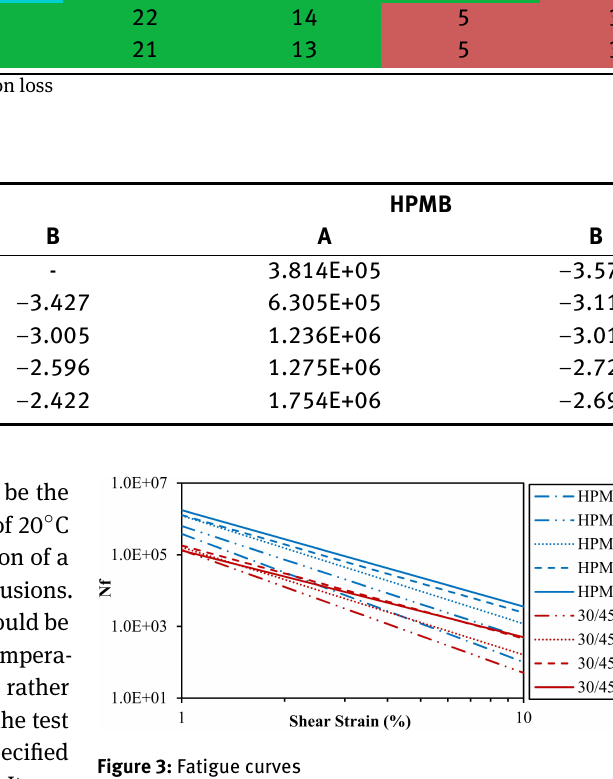
Figure 3: Fatigue